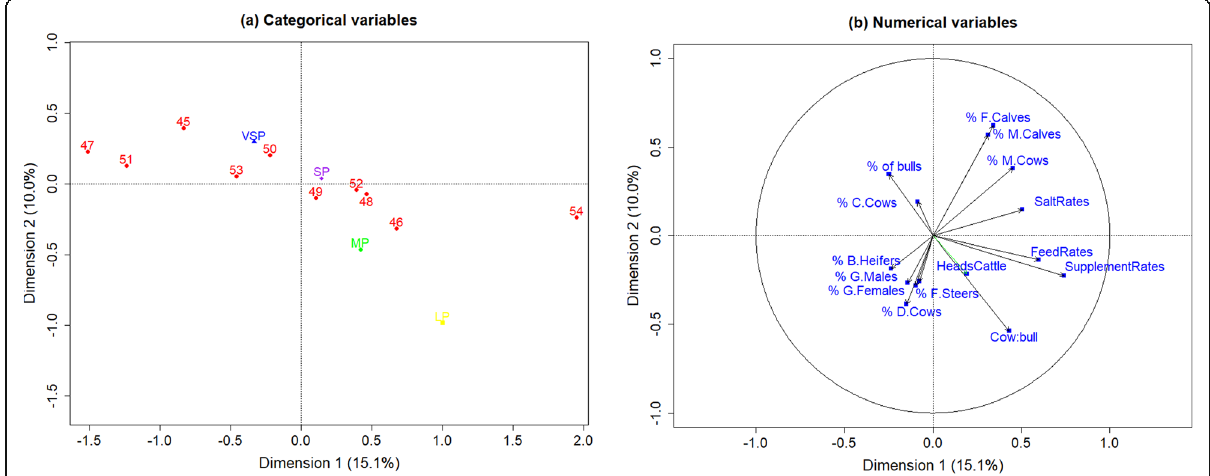
Fig. 3 Spatial projection of a categorical variables and b numerical variables for the component Herd Composition and Management. Coding of categorical and numerical variables is shown in Table S3 of the Supplementary material